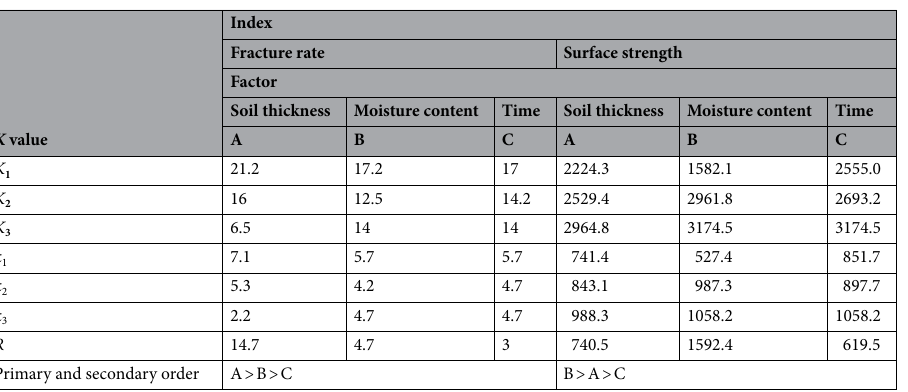
Table 6. Range analysis of dry shrinkage orthogonal test